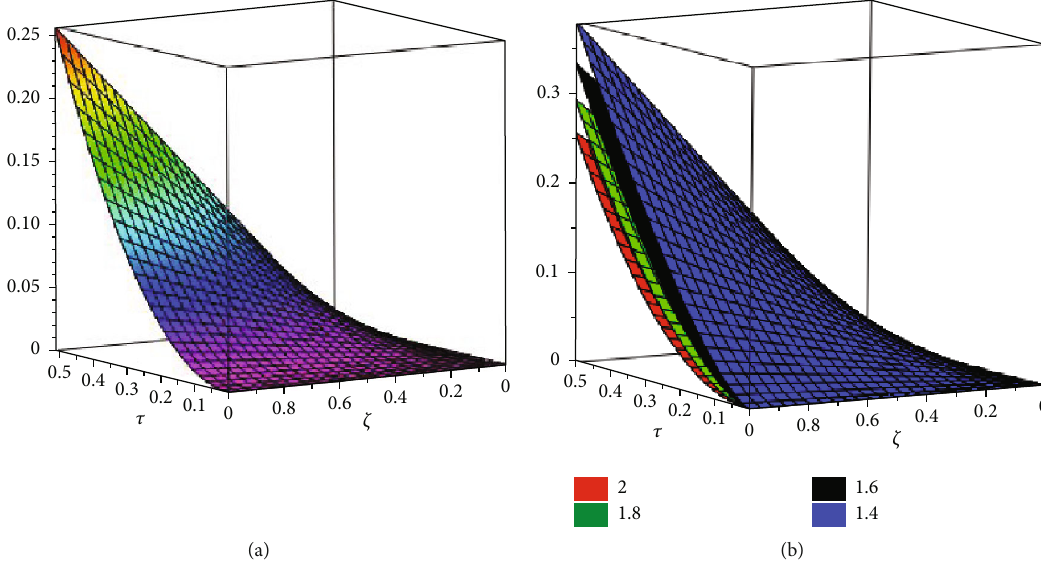
Figure 1: (a) Exact and an approximate graph of problem 1 and (b) di ff erent fractional-order graphs of problem